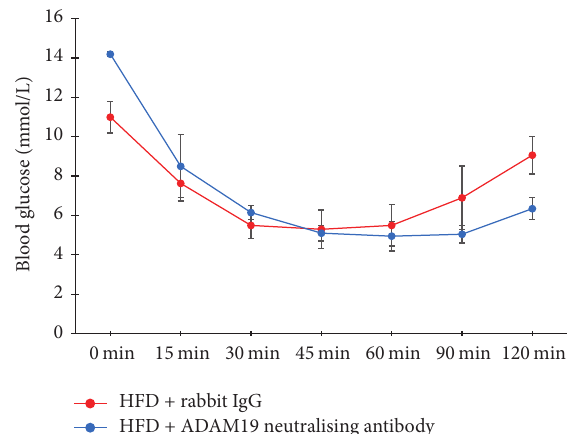
Figure 6: Neutralisation of ADAM19 improves insulin sensitivity in HFD-fed mice. Mean ± SEM; 𝑛 = 3 mice/group.